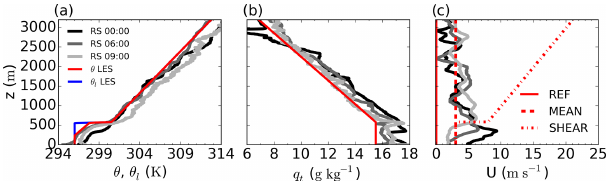
Figure 1. Vertical profiles of potential temperature (a) , total spe- cific humidity (b) and wind (c) as observed through radioson- des (at 00:00, 06:00 and 09:00UTC from black to light grey) on 26 June 2016 and as prescribed in the idealized LES experiments (red and blue). The three experiments REF, MEAN and SHEAR differ only in the prescribed wind